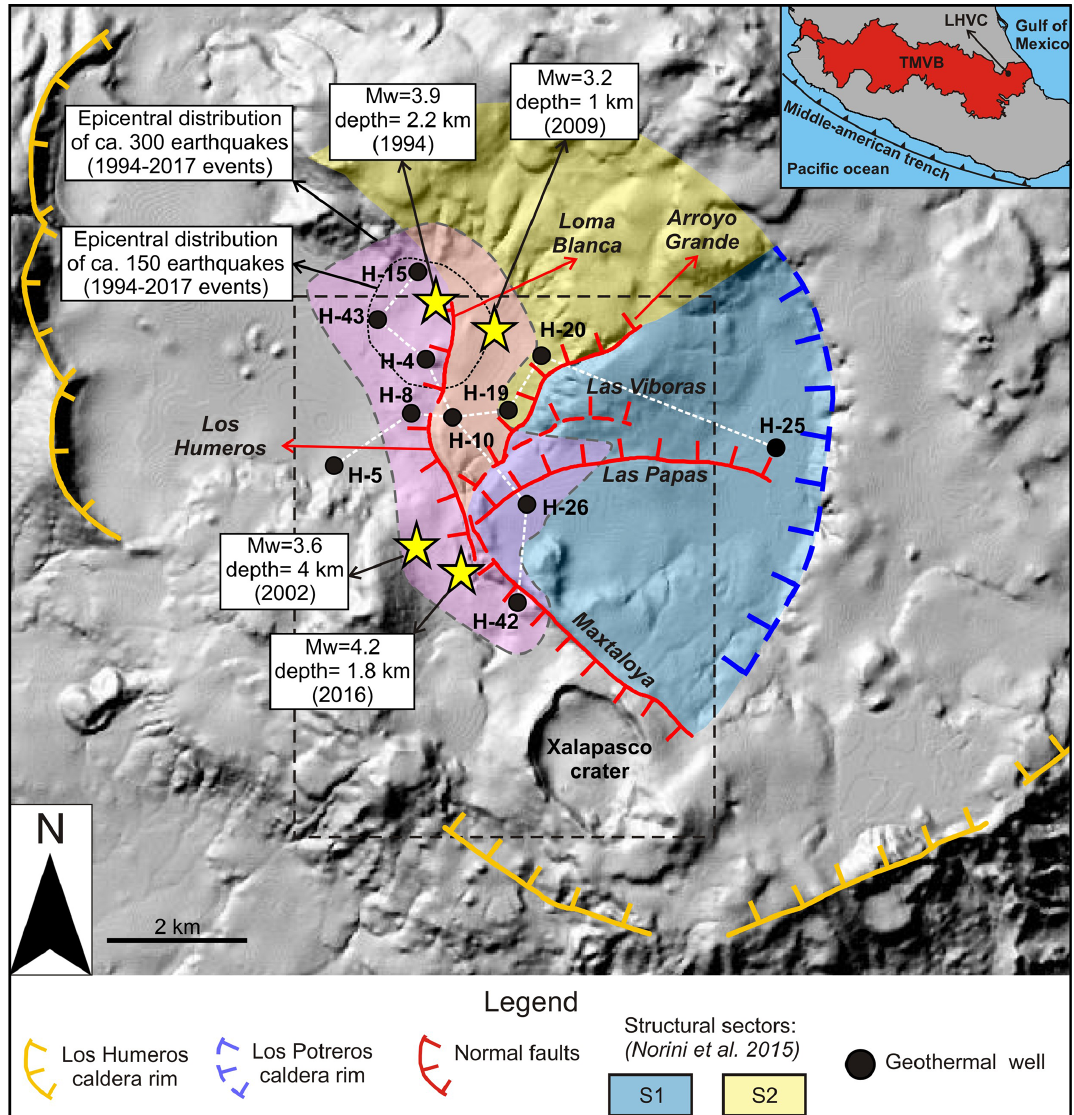
Figure 1. Shaded relief image (illuminated from the NE) obtained from a 15m resolution digital elevation model (DEM) of the Los Humeros volcanic complex (LHVC) showing the main structural features (faults and caldera rim; modified from Norini et al., 2015; Calcagno et al., 2018) and some geothermal wells referred to in the text and in Figs. 2a–b. The white dashed lines indicate the direction of the correlation sections shown in Fig. 2a–b. The black rectangle indicates the studied area within the Los Potreros caldera shown in Fig. 4. The inset box shows the location of the LHVC (black dot and arrow) within the eastern sector of the Trans-Mexican Volcanic Belt (TMVB). The structural sectors S1 and S2 correspond to the resurgent block inferred by Norini et al. (2015). Seismicity data are from Lermo et al.